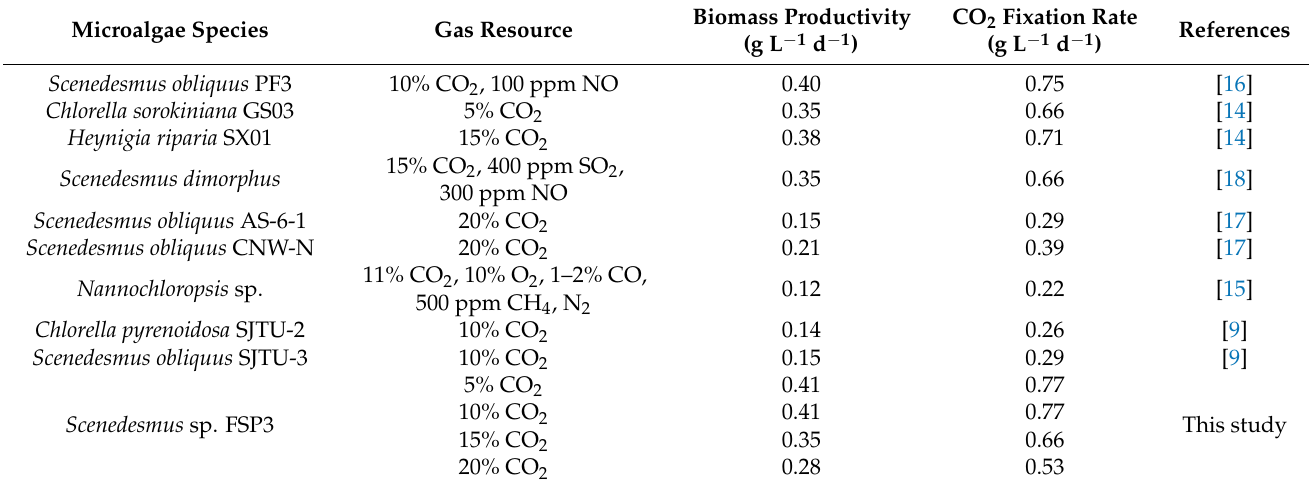
Table 1. Comparison of maximum biomass productivity and CO 2 fixation rates for different